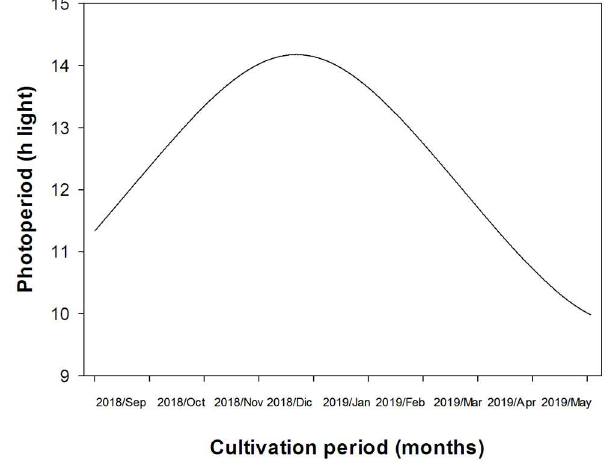
Figure 2. Photoperiod (h light) recorded in La Cruz-Chile during the 2018–2019 cultivation season. The database can be accessed by request.